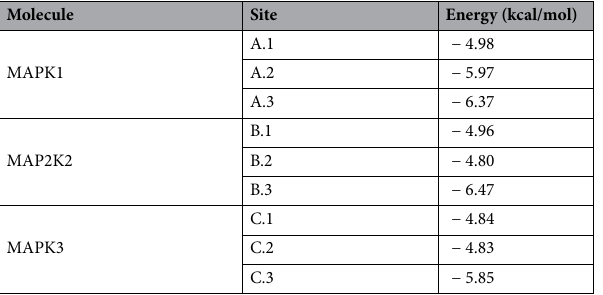
Table 2. The binding energies of LrB to different sites in MAPK1, MAP2K2 and MAPK3. The lower the binding energy, the better the binding ability. It represented the sites of LrB and MAPK1, MAP2K2 and MAPK3 were best that the binding energies of A.3, B.3 and C.3 were lowest in each group.